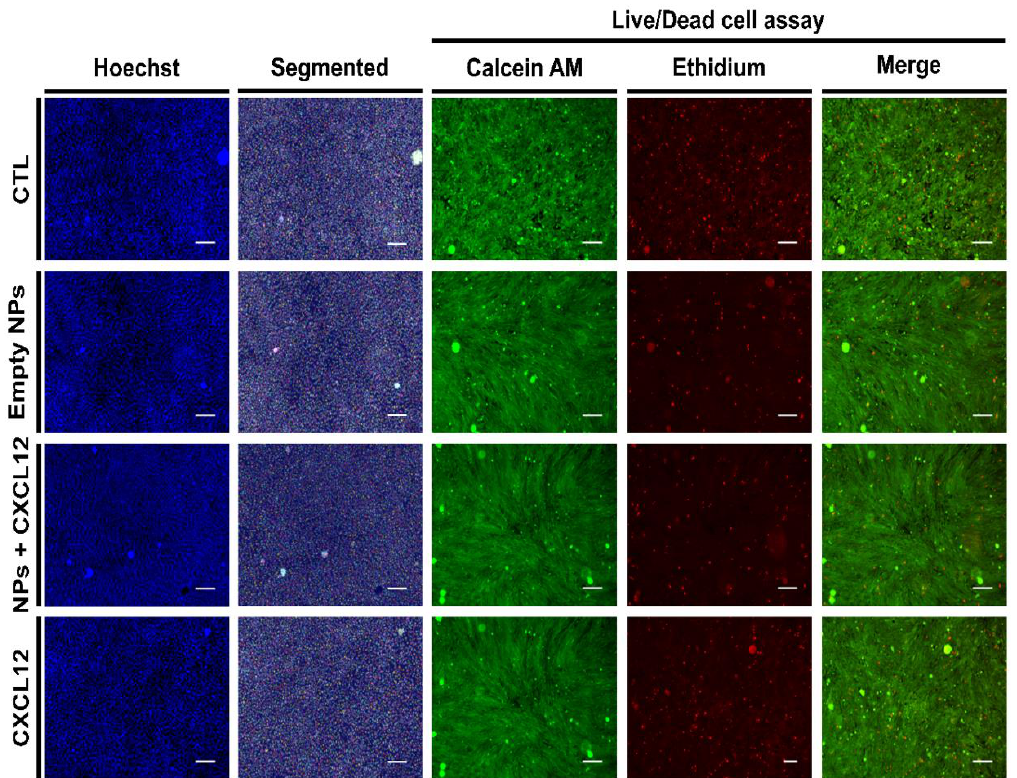
Figure 6. Representative Hoechst, segmented Hoechst (Segmented) and live/dead images for F98 cells incubated for 72 h with empty NPs, NPs-CXCL12 (0.744 µg/mg NPs) and CXCL12 (0.8 µg/mL). Bar = 100 µm. Results are representative of three independent experiments performed in duplicate.